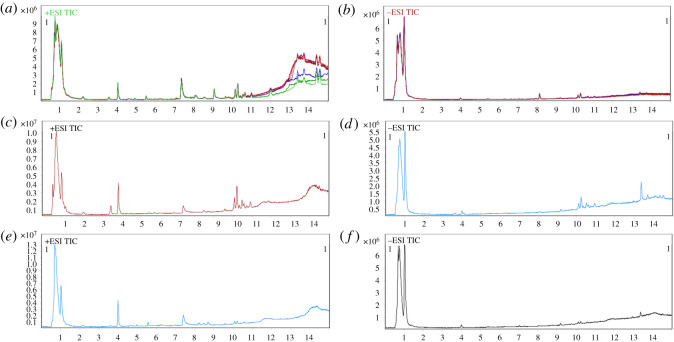
Typical UPLC-MS TIC chromatograms of (a) QC in positive ion mode; (b) QC in negative ion mode; (c) the control sample in positive ion mode; (c) the control sample in negative ion mode; (e) 9,10-PQ sample in positive ion mode; (f) 9,10-PQ sample in negative ion mode.